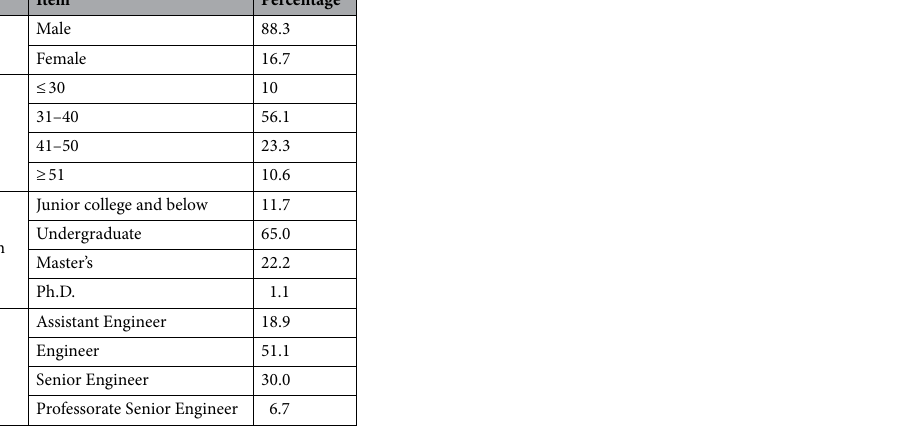
Table 5. Respondent demographics ( n = 180).